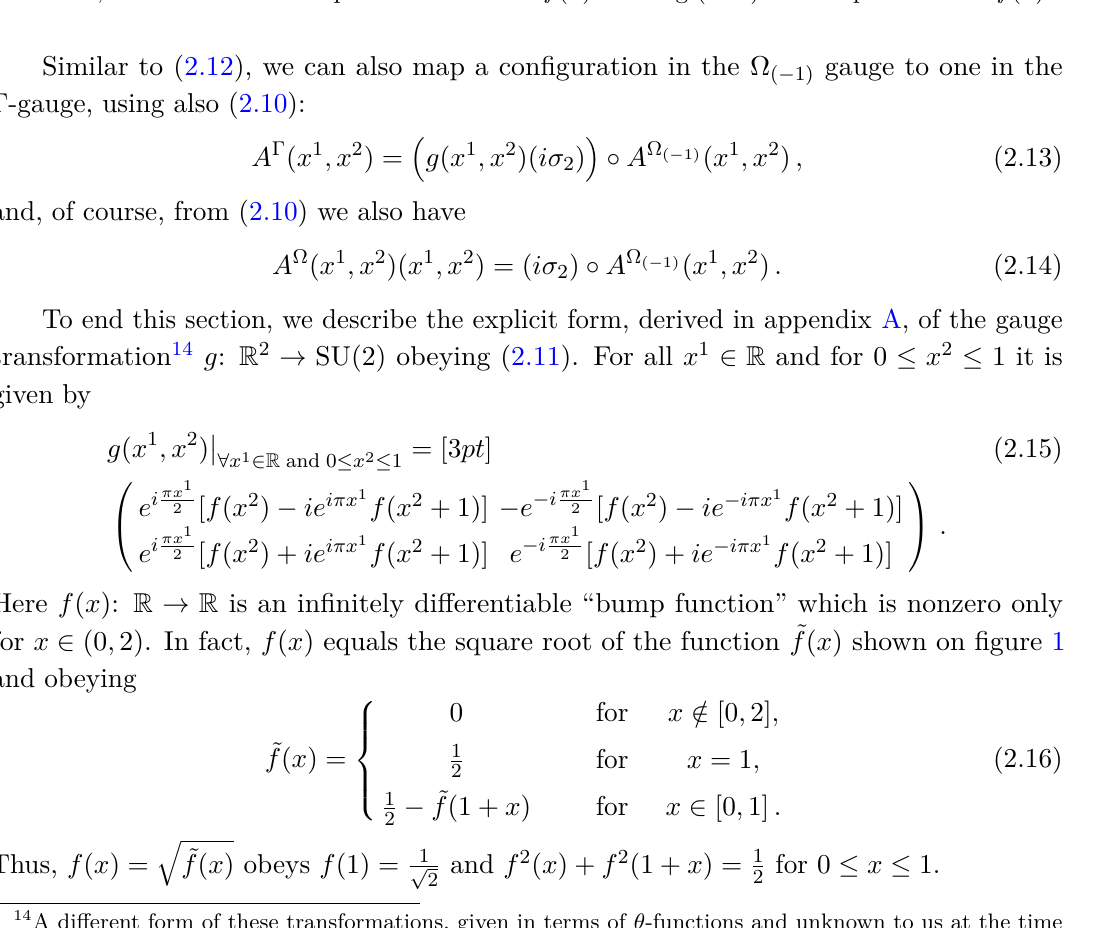
Figure 1 . A plot of the infinitely differentiable function obeying (2.16). Its construction using a “bump function” h ( x ) ∼ e − 1 4 x (1 − x ) , only nonzero for 0 < x < 1 , is illustrated on the plot. The function f ( x ) entering (2.15) is the square root of ˜ f ( x )